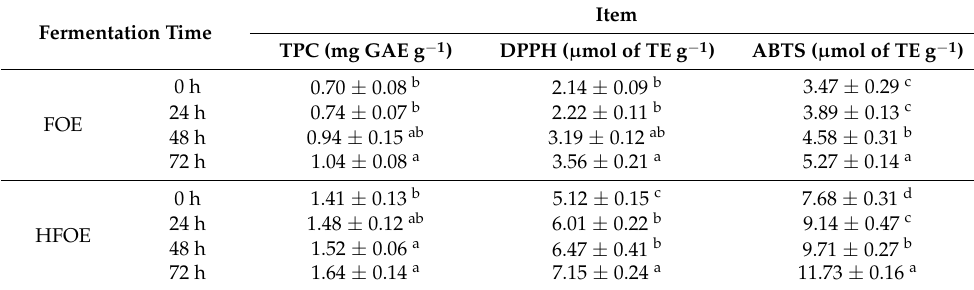
Table 2. Total phenolic content (TPC) and potential antioxidant activities in FOE and HFOE during fermentation up to 72 h (mean ± SE), n =